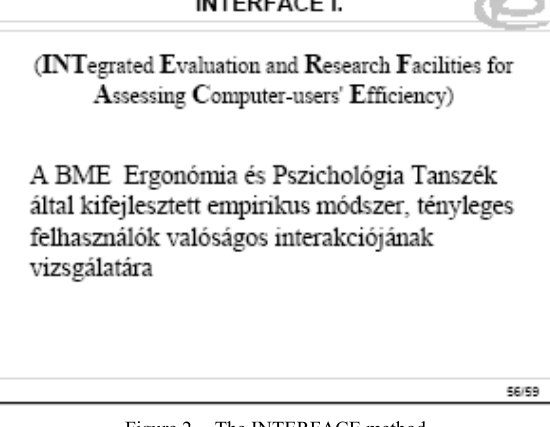
Figure 2. The INTERFACE method Figure 3. The essence of